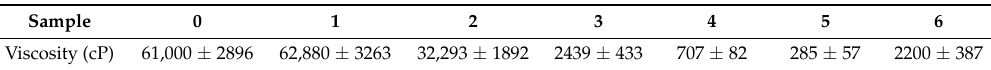
Table 2. Initial viscosity of different adhesive samples: 0 (12 wt% SPI), 1 (18 wt% SPI/bromelain), 2 (18 wt% SPI/bromelain/3 wt% TGA), 3 (18 wt% SPI/bromelain/6wt% TGA), 4 (18